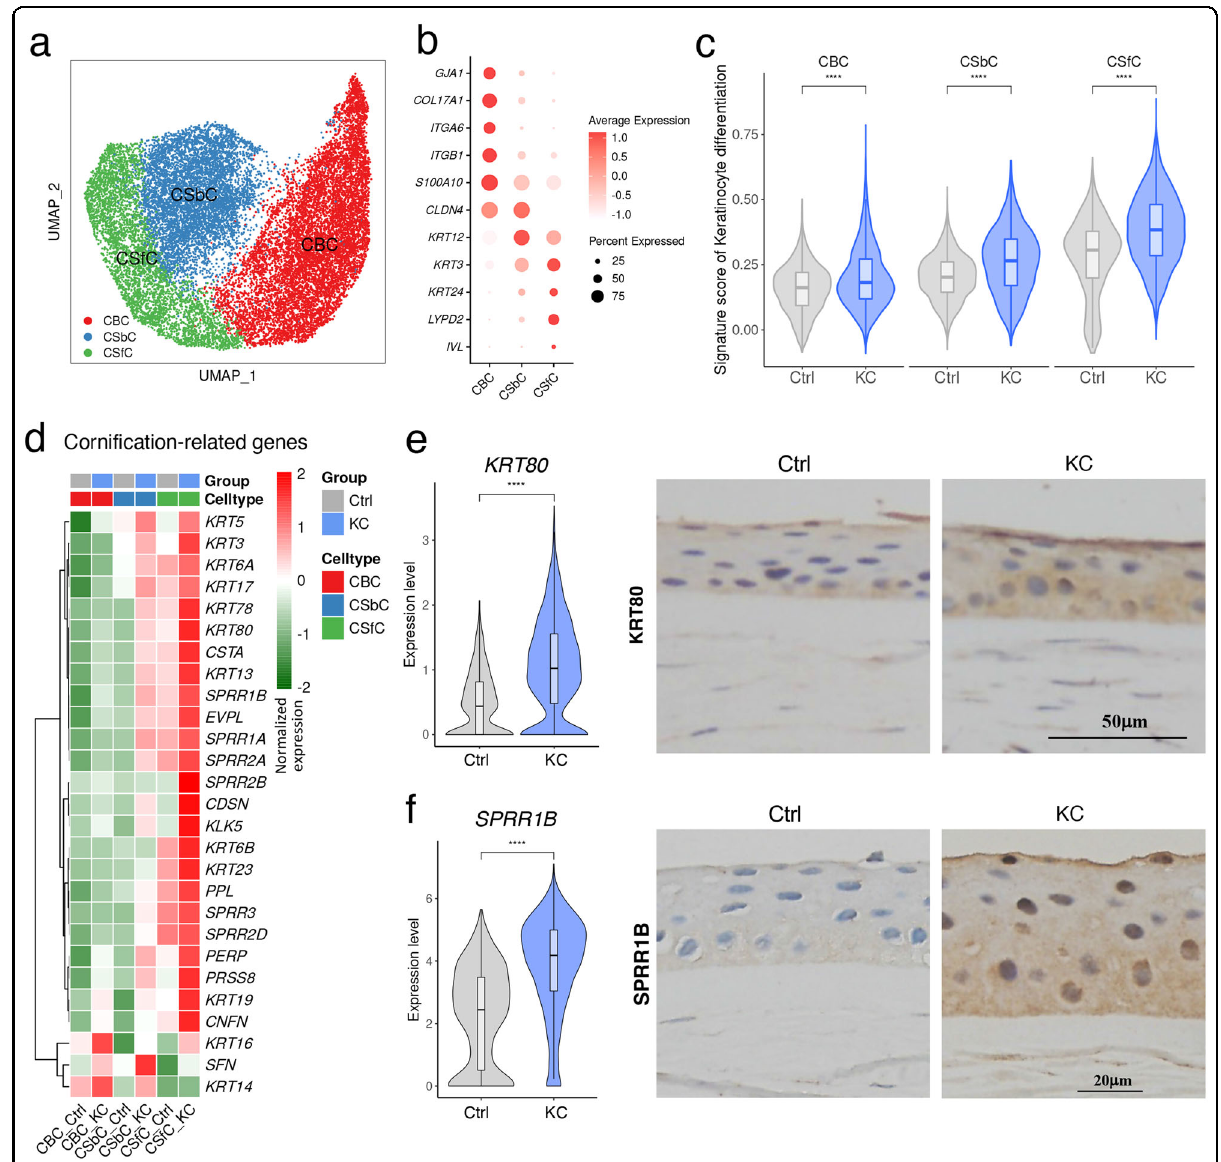
Fig. 4 Heterogeneous transcriptional changes in keratoconus corneal epithelium. a UMAP plot of corneal epithelial cells colored by annotated cell types. b Dot plot showing expression patterns of representative markers for each cell type. c Gene scoring analysis using keratinocyte differentiation-related genes. **** P < 0.0001 (two-sided Wilcoxon rank-sum test). d Expression pro fi ling for corni fi cation-related genes across cell subtypes and groups. e , f Expression level of KRT80 ( e ) and SPRR1B ( f ) in Ctrl and KC super fi cial cells (left panel), and immunohistochemical analysis con fi rmed their elevated expression in KC samples (right panel). **** P < 0.0001 (two-sided Wilcoxon rank-sum